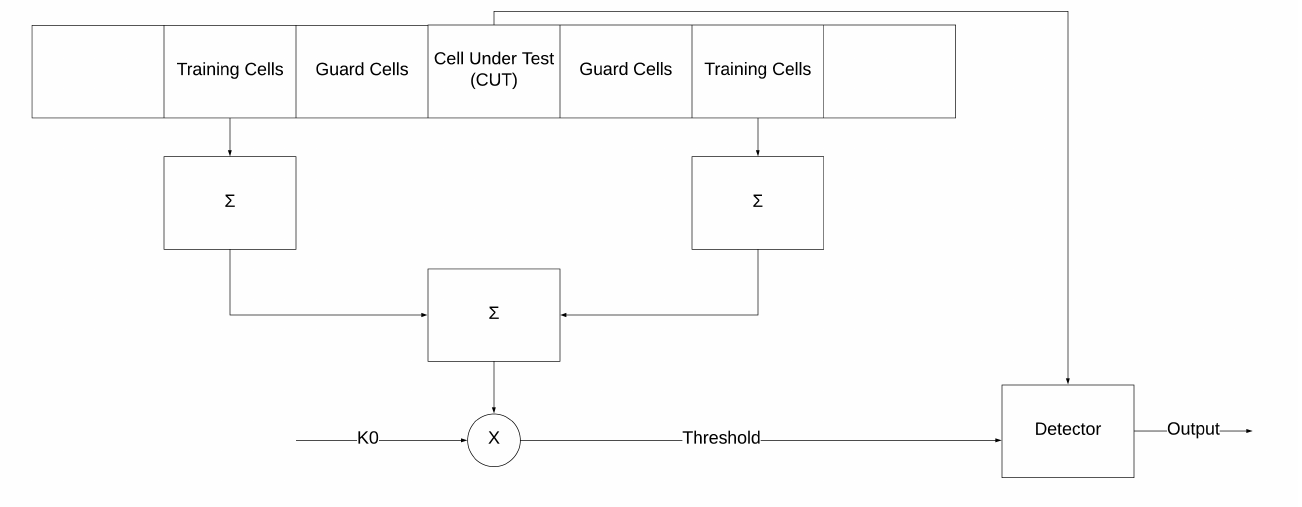
Figure 10. CA-CFAR